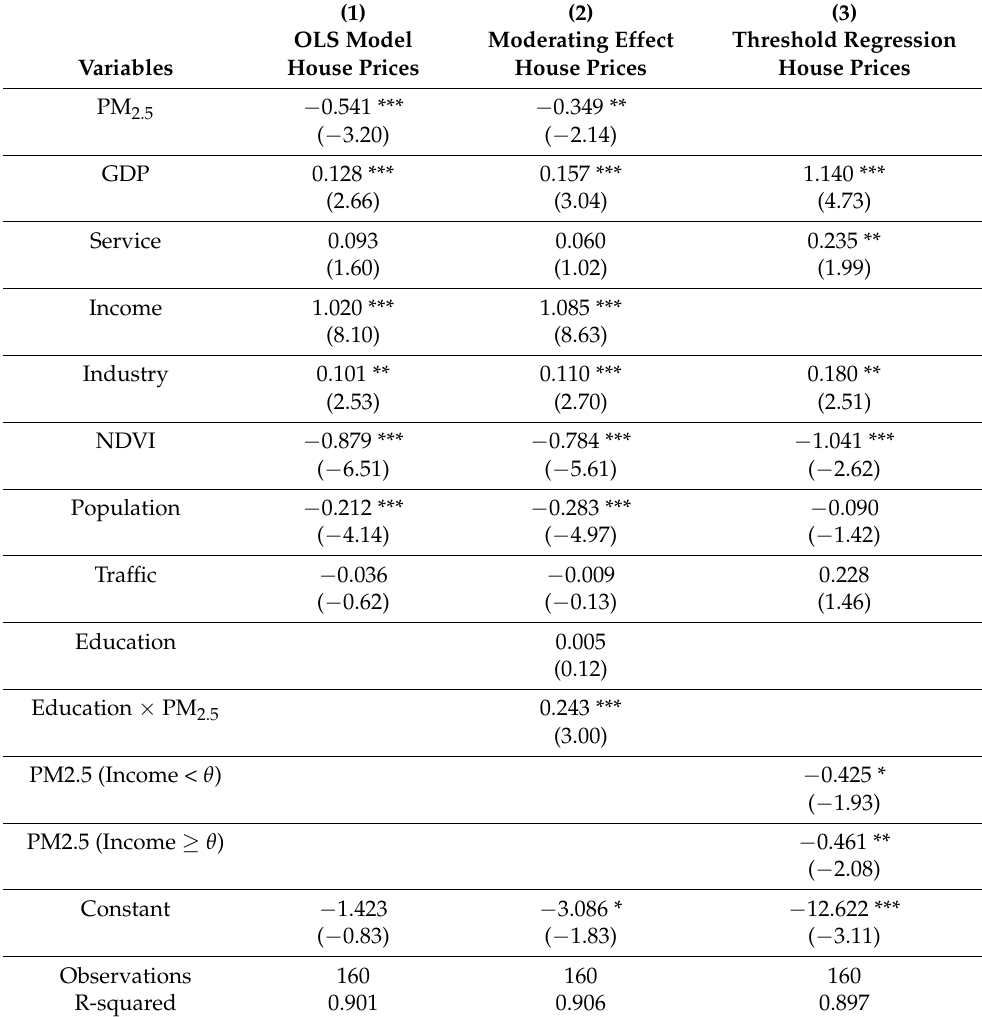
Table 3. The regression results of the OLS estimation, moderating effect and threshold